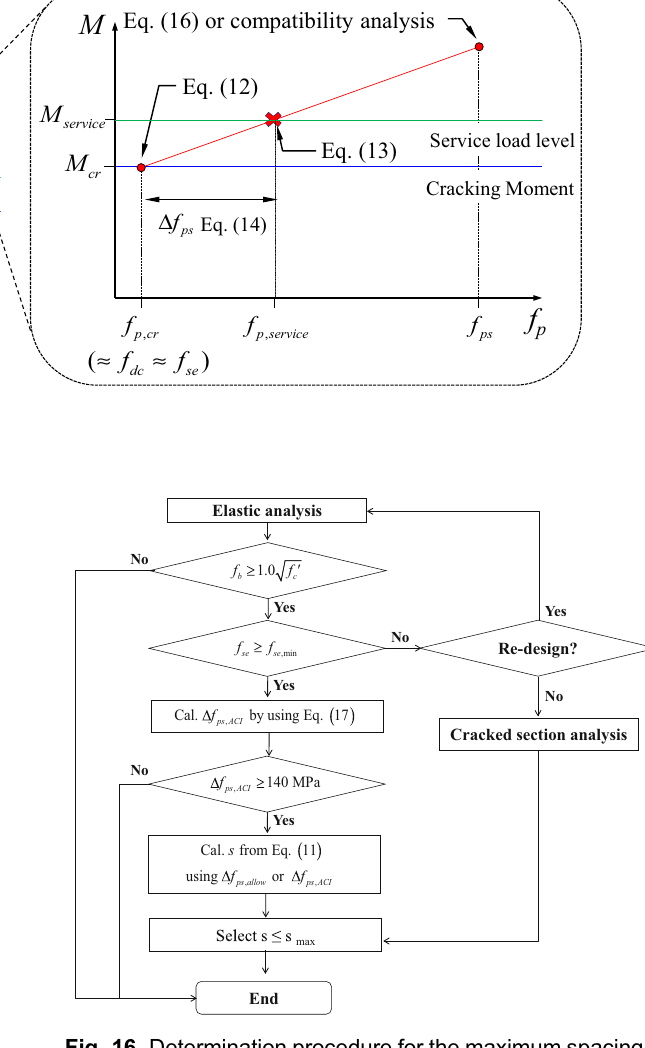
Fig. 15 Comparison of analysis results by simple and detailed method.